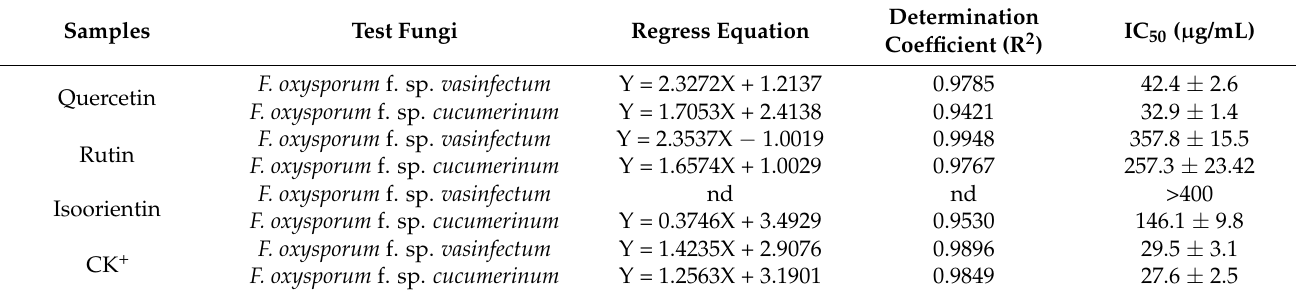
Table 3. The IC 50 values of quercetin, rutin, and isoorientin against the spore germination of two pathogenic